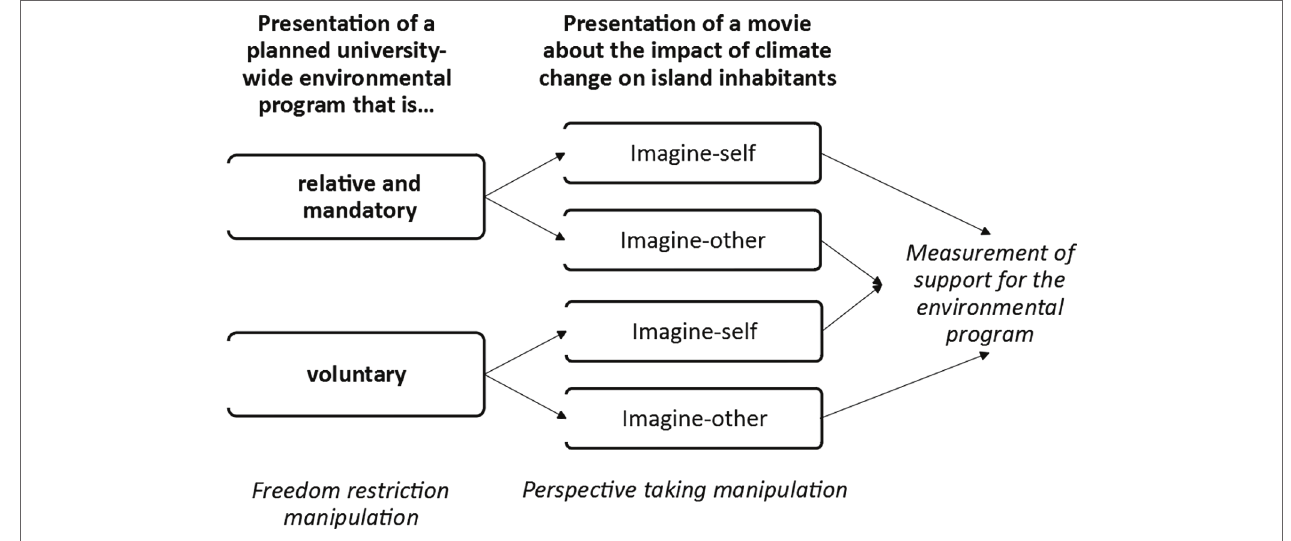
FIGURE 2 | Design of study 2.